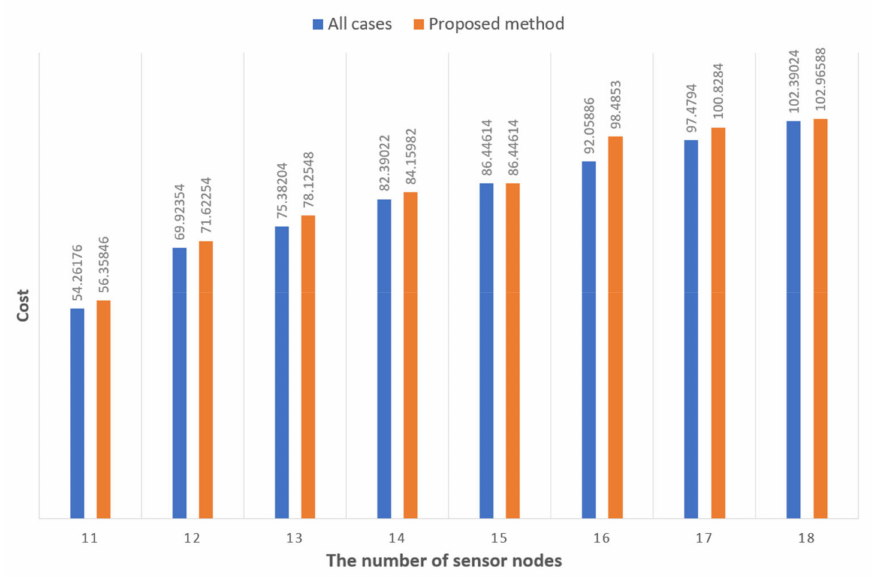
Figure 7. Comparison of the costs in two methods.